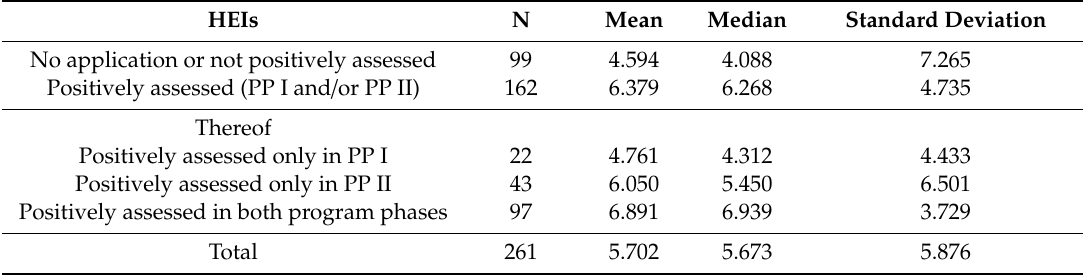
Table 2. Comparison of Means: Increase in the Proportion of Women Professors between 2007 and 2015 by Participation in the Women Professors Program. HEIs N Mean Median Standard